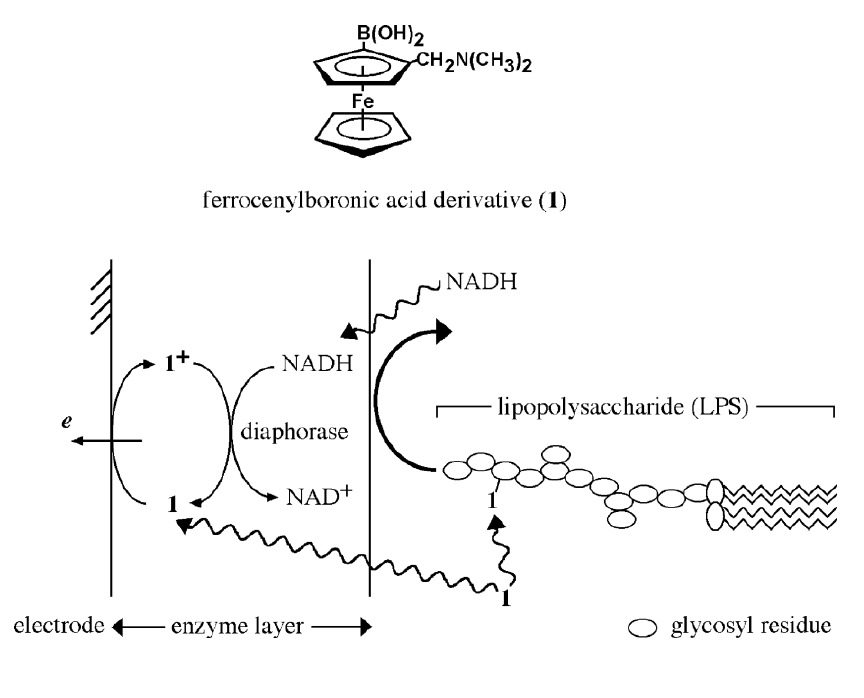
Figure 5. Chemical structure of N , N -dimethylaminomethyl-substituted FcBA ( 1 ) and a schematic illustration of reaction of LPS sensing by enzyme-modified electrode. Reprinted with permission from Kato et al . [14]. Copyright (2007)